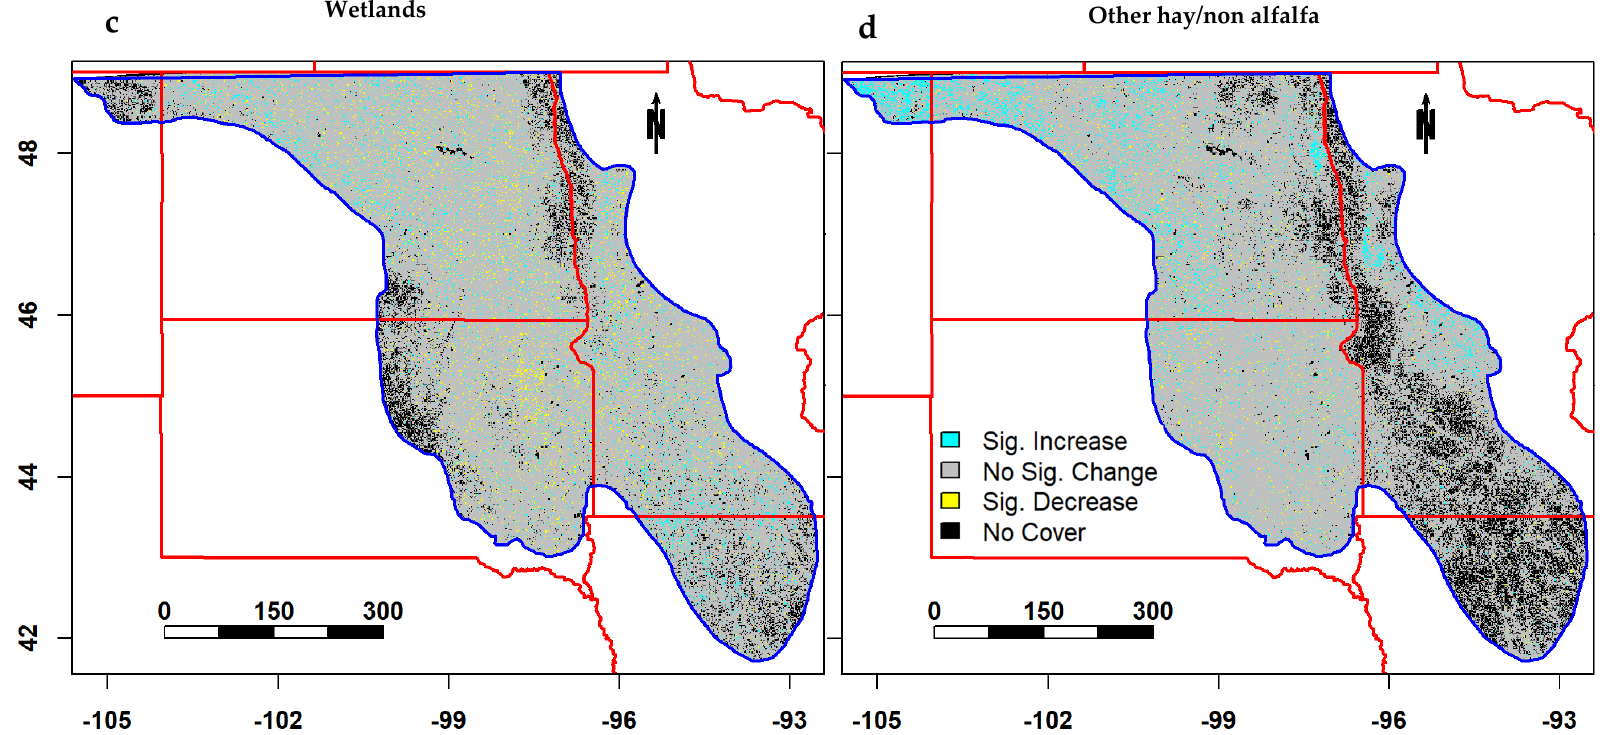
Figure 4. ( a , b ). Mann-Kendall trend maps of cover classes between 2006 and 2018. Each cover class is divided into four categories: significant gains (cyan; p < 0.05), no significant change (gray; p > 0.05), significant losses (yellow; p < 0.05), with cover class absence in black. Quantitative details about these trends are presented in Figure 5 and Table S1. ( c , d ). Mann-Kendall trend maps of cover classes between 2006 and 2018. Each cover class is divided into four categories: significant gains (cyan; p < 0.05), no significant change (gray; p > 0.05), significant losses (yellow; p < 0.05), with cover class absence in black. Quantitative details about these trends are presented in Figure 5 and Table S1. Similar maps for the other crop / land covers appear in Figure